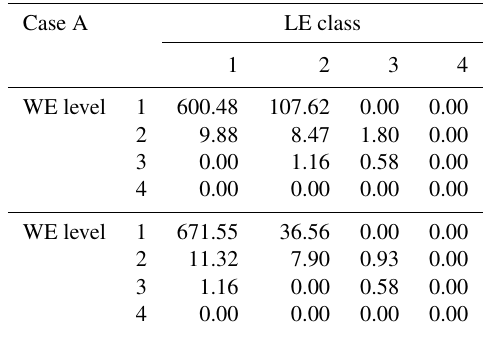
Table 5. Duration matrices for cases A and B; units of time are expressed in days.